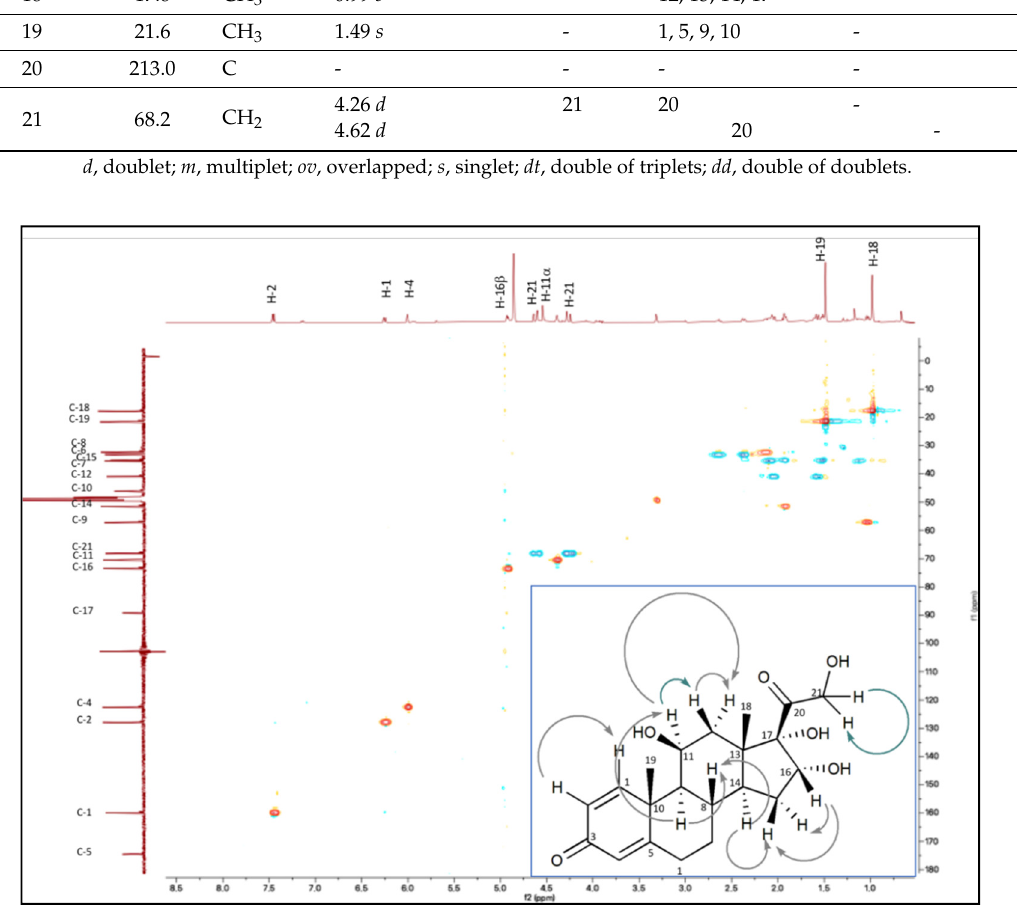
Figure 7. Selected HSQC correlations of 16 α -OH prednisolone obtained by bioconversion of HC by coupling A. simplex and S. roseochromogenes. In the figure COSY correlations are shown.